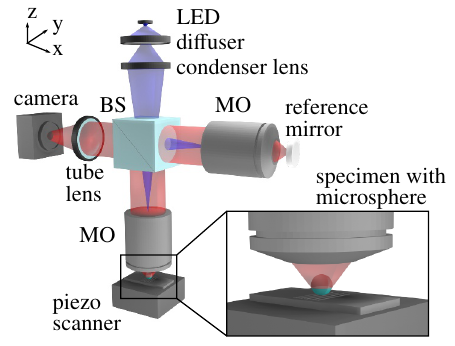
Figure 1: Schematic representation of the microsphere assisted Linnik interferometer containing two high NA microscope objectives (MO) and a beam splitter (BS). The illumination (blue) and imaging (red) beam paths are